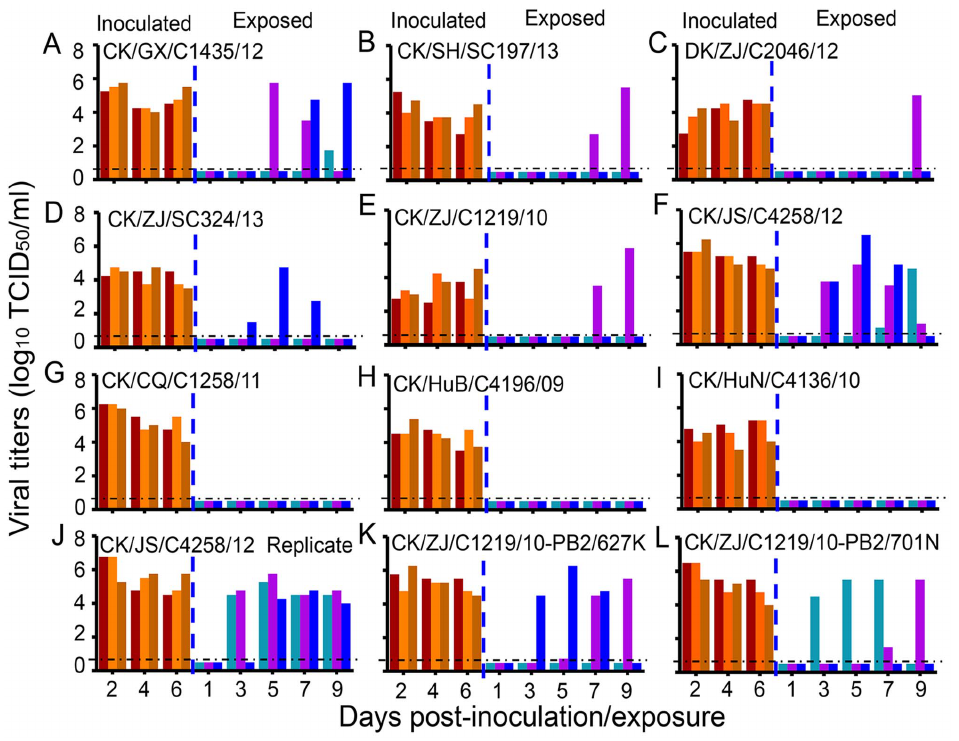
Figure 6. Respiratory droplet transmission of H9N2 viruses in ferrets. ( A ) CK/GX/C1435/12. ( B ) CK/SH/SC197/13. ( C ) DK/ZJ/C2046/12. ( D ) CK/ZJ/SC324/13. ( E ) CK/ZJ/C1219/10. ( F ) CK/JS/C4258/12. ( G ) CK/CQ/C1258/11. ( H ) CK/HuB/C4196/09. ( I ) CK/HuN/C4136/10. ( J ) CK/JS/C4258/12 (replicate). ( K ) CK/ZJ/C1219/10-PB2/627K. ( L ) CK/ZJ/C1219/10-PB2/701N. Each color bar represents the virus titer from an individual animal. The dashed black lines indicate the lower limit of detection.